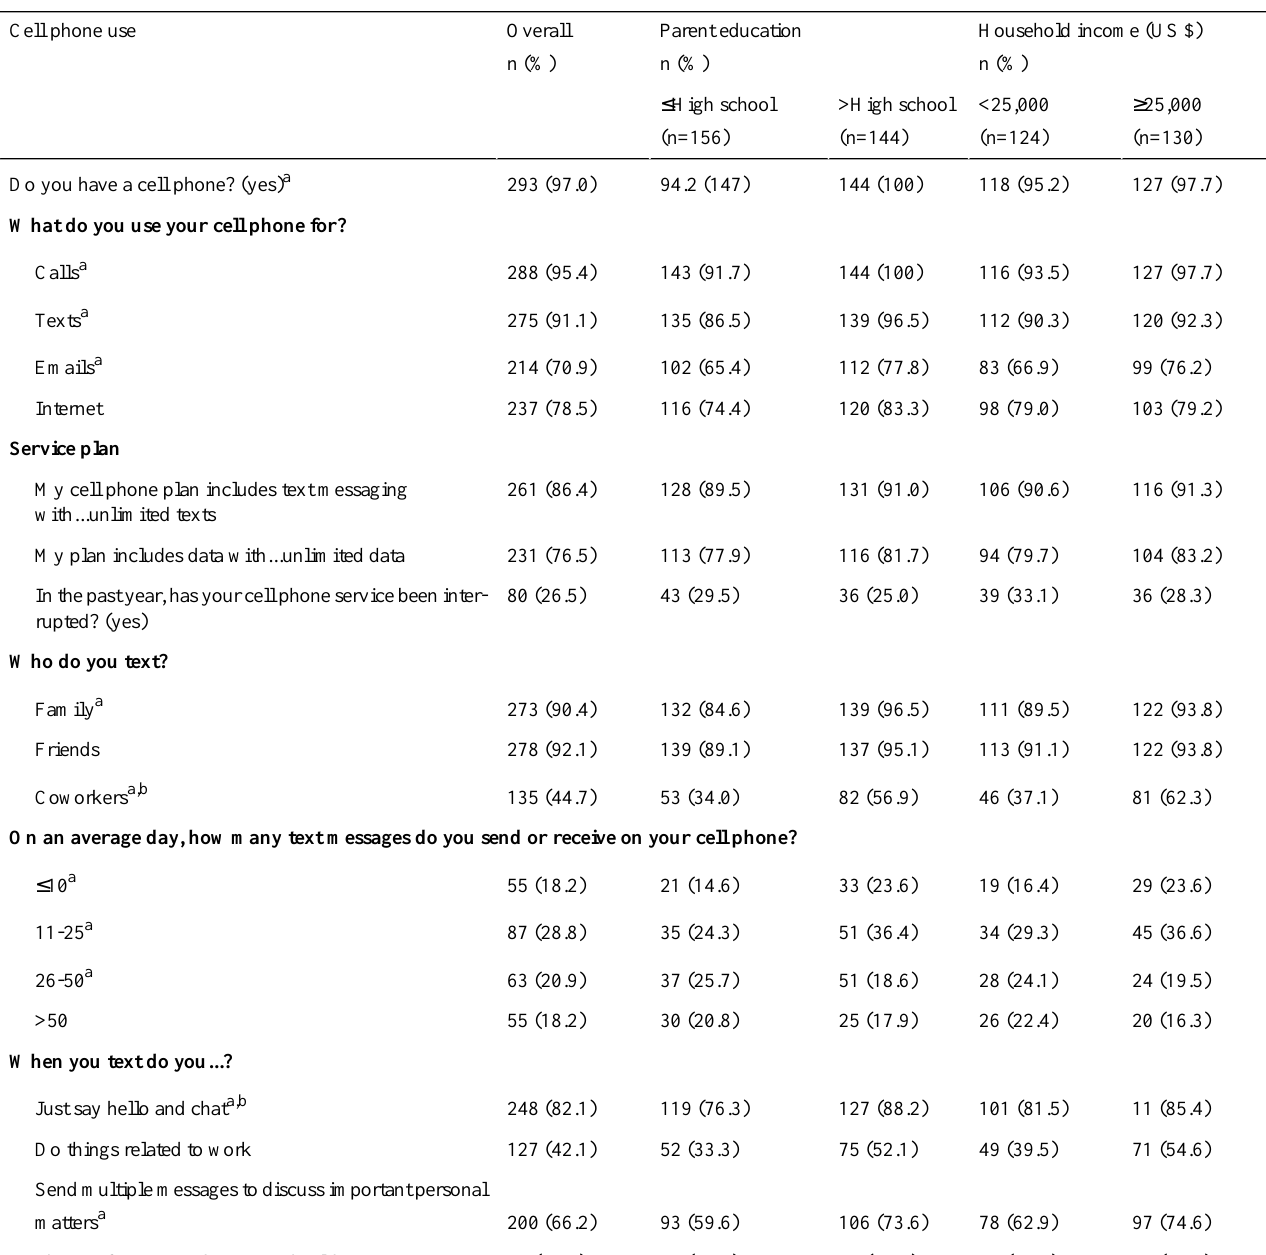
Table 2. Participant cell phone use by education and income (N=302).